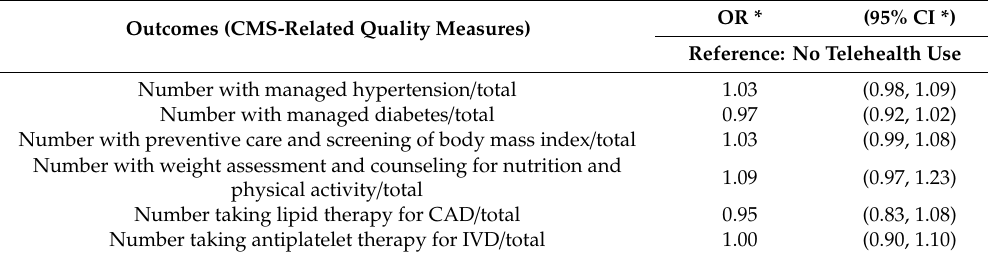
Table 2. Analyzing the associations between telehealth use and the management of cardio-metabolic syndrome-related quality measures.